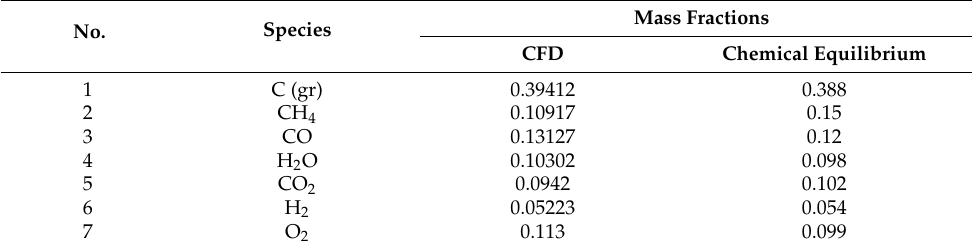
Table 11. Species mass fraction (CFD) and chemical equilibrium calculations at exit plane of